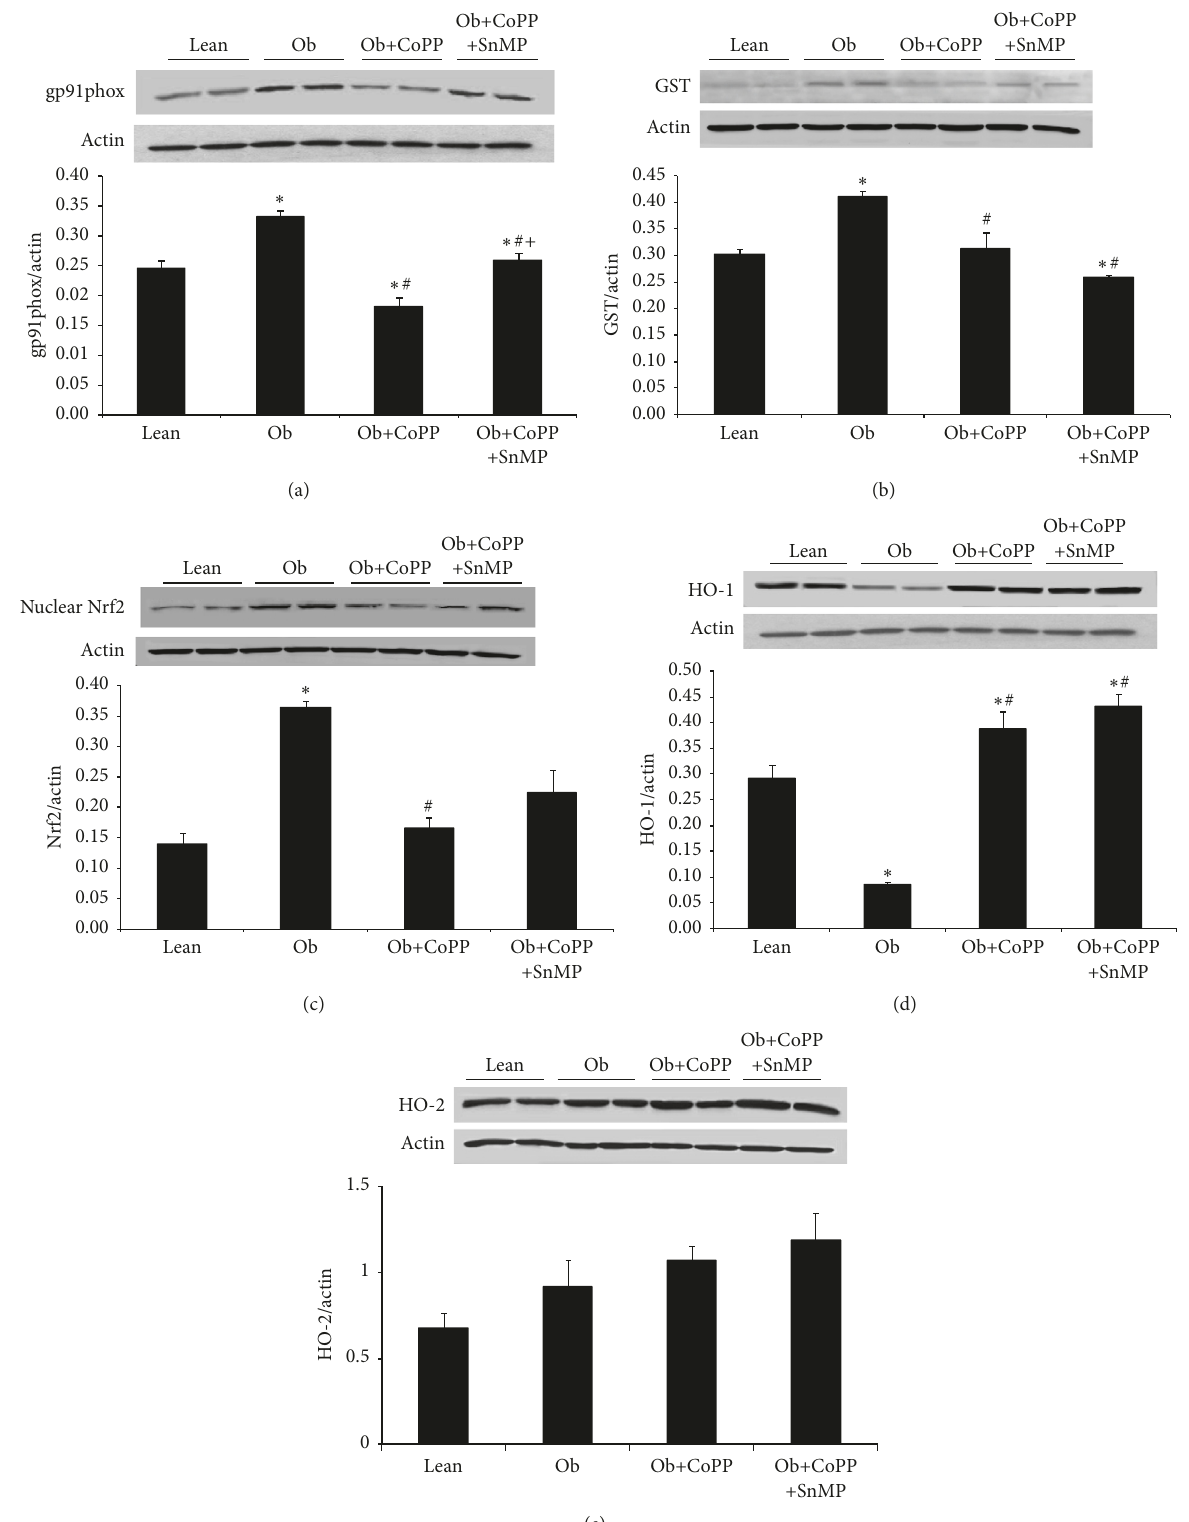
Figure 2: Effect of HO-1 induction on gp91phox, GST, and nuclear NRF2 protein levels in liver of lean and obese mice. Western blot and densitometry analysis of (a) gp91phox, (b) GST, (c) nuclear NRF2, (d) HO-1, and (e) HO-2 protein levels. Results are mean ± SEM of the band density normalized to actin. 𝑛 = 3 -4, ∗ 𝑝 < 0.05 versus lean; # 𝑝 < 0.05 versus obese; + 𝑝 < 0.05 versus obese